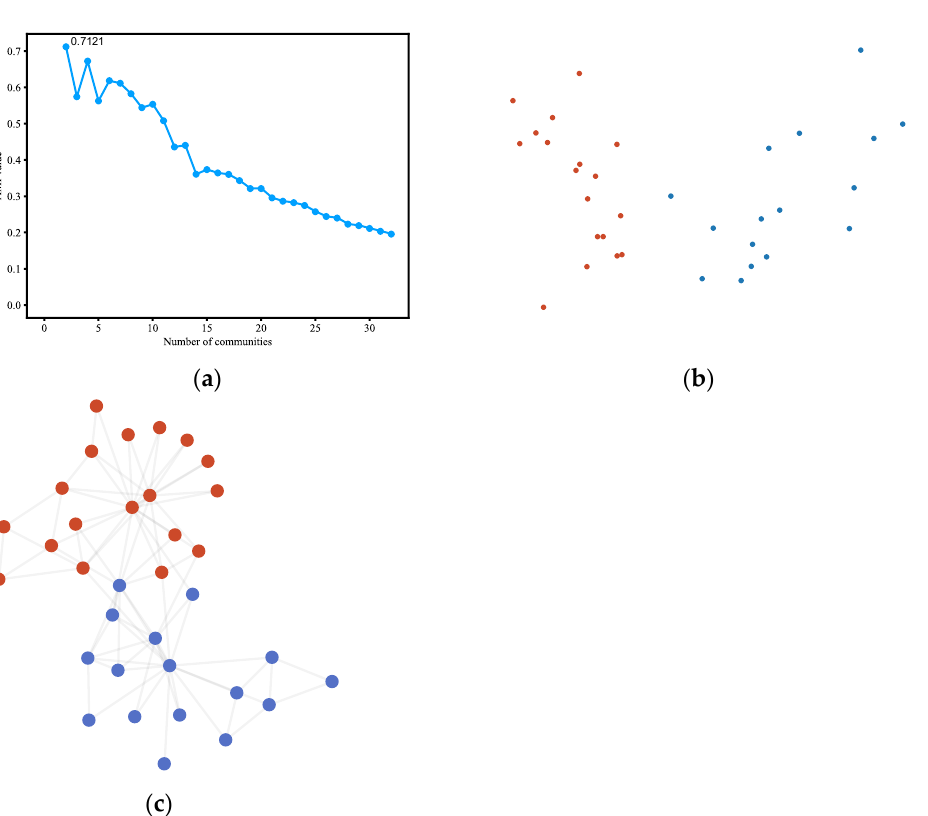
Figure 2. ( a ) AMI variation graph of adjacent partitions of Karate Club, with the abscissa indicating the number of communities and the ordinate indicating the AMI values between the corresponding partitions and their previous partitions. ( b )Vectors representing each node of Karate Club (reduced to 2D using PCA). ( c ) Result of community detection on Karate Club. Table 2. Results of AMI-NRL and the other community detection algorithms on Karate Club.